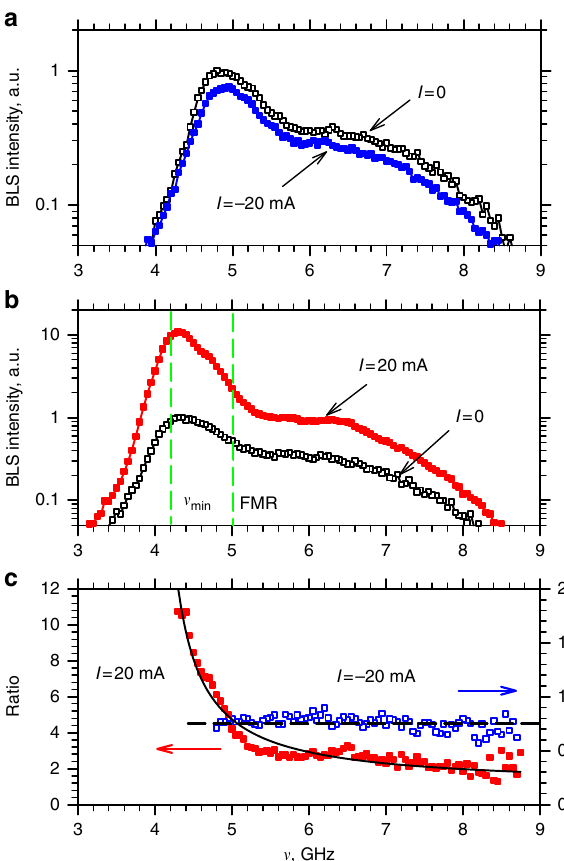
Fig. 3 Spectral distribution of spin current-driven magnon population. a , b BLS spectra recorded at I = − 20 and 20 mA, respectively, (solid symbols) together with the reference spectrum obtained at I = 0 (open symbols) shifted in frequency by the value determined from the data of Fig. 2c. Vertical dashed lines in b mark the frequency ν min of the lowest-energy magnon state, and that of the quasi-uniform FMR mode. Note the logarithmic scale on the vertical axis. c The ratio of the spectra obtained with and without current. Dashed line is the mean value of the ratio for I = − 20 mA. Solid curve is the fi t of the ratio for I = 20 mA by Eq. (1), with T = T μ / h = 3.94 GHz 0 and